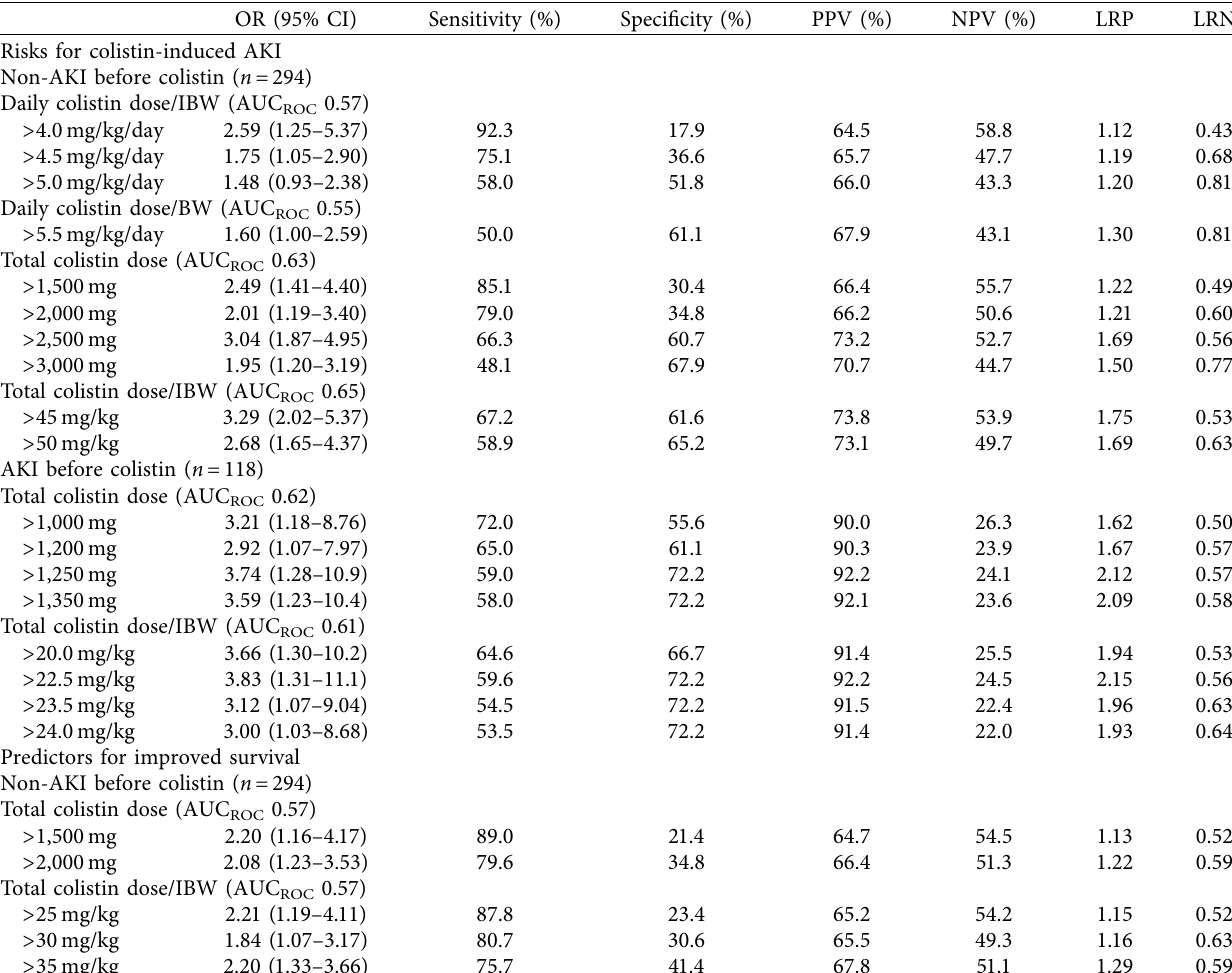
Table 5: Predictors of total and daily colistin dosages as the risks of acute kidney injury and benefactors of mortality